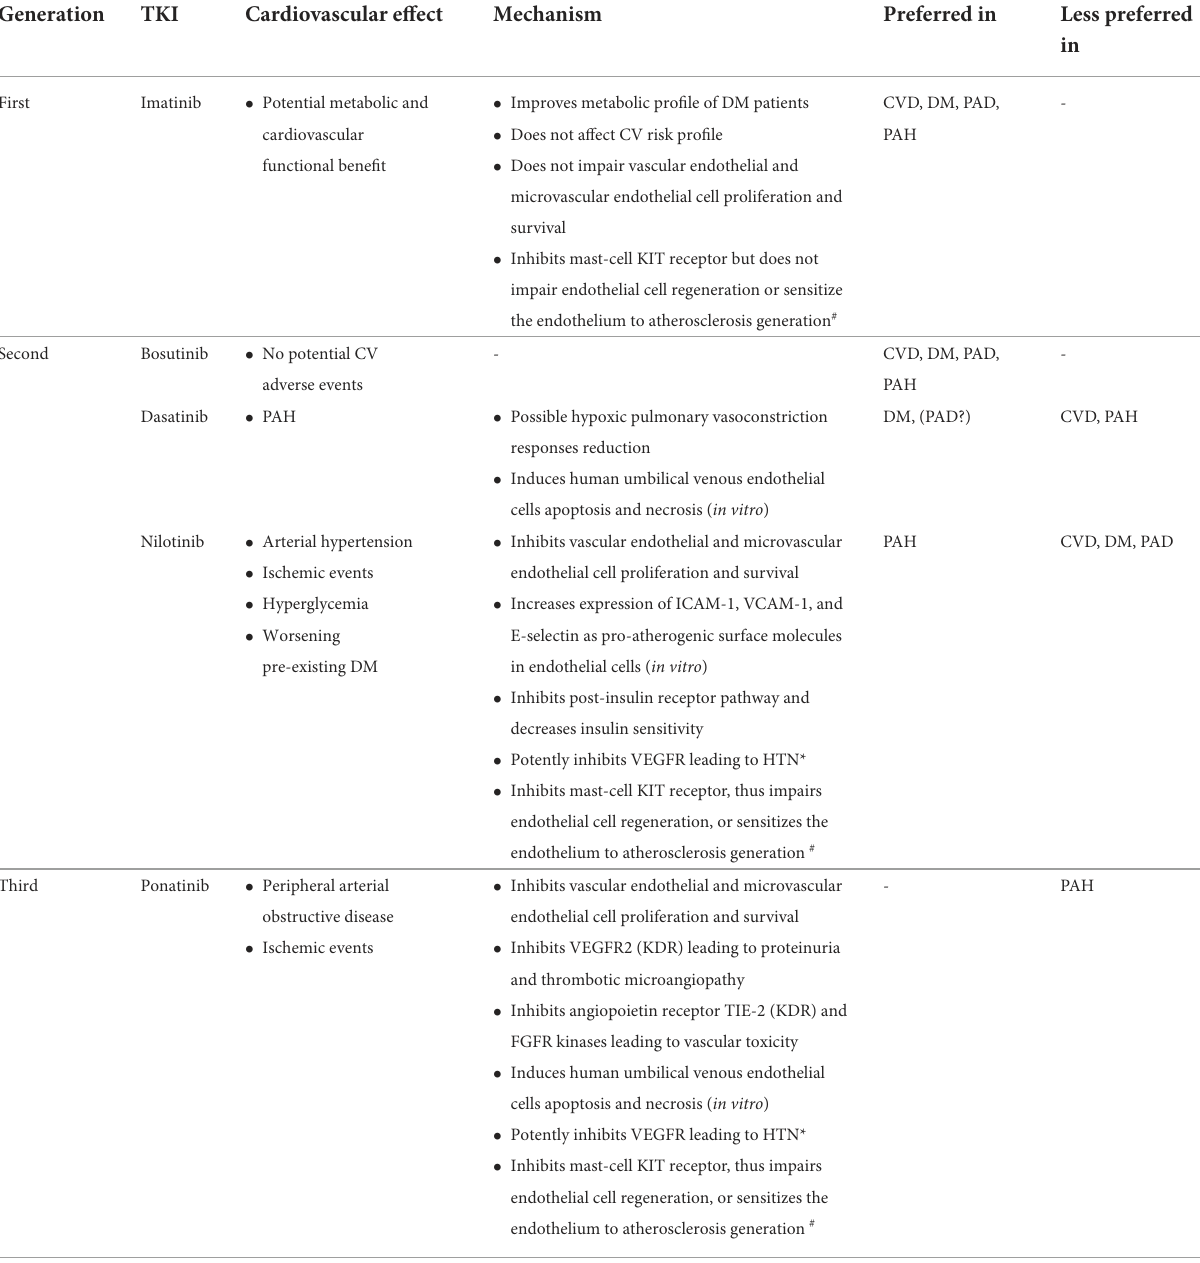
TABLE 1 Mechanism of cardiovascular adverse events of